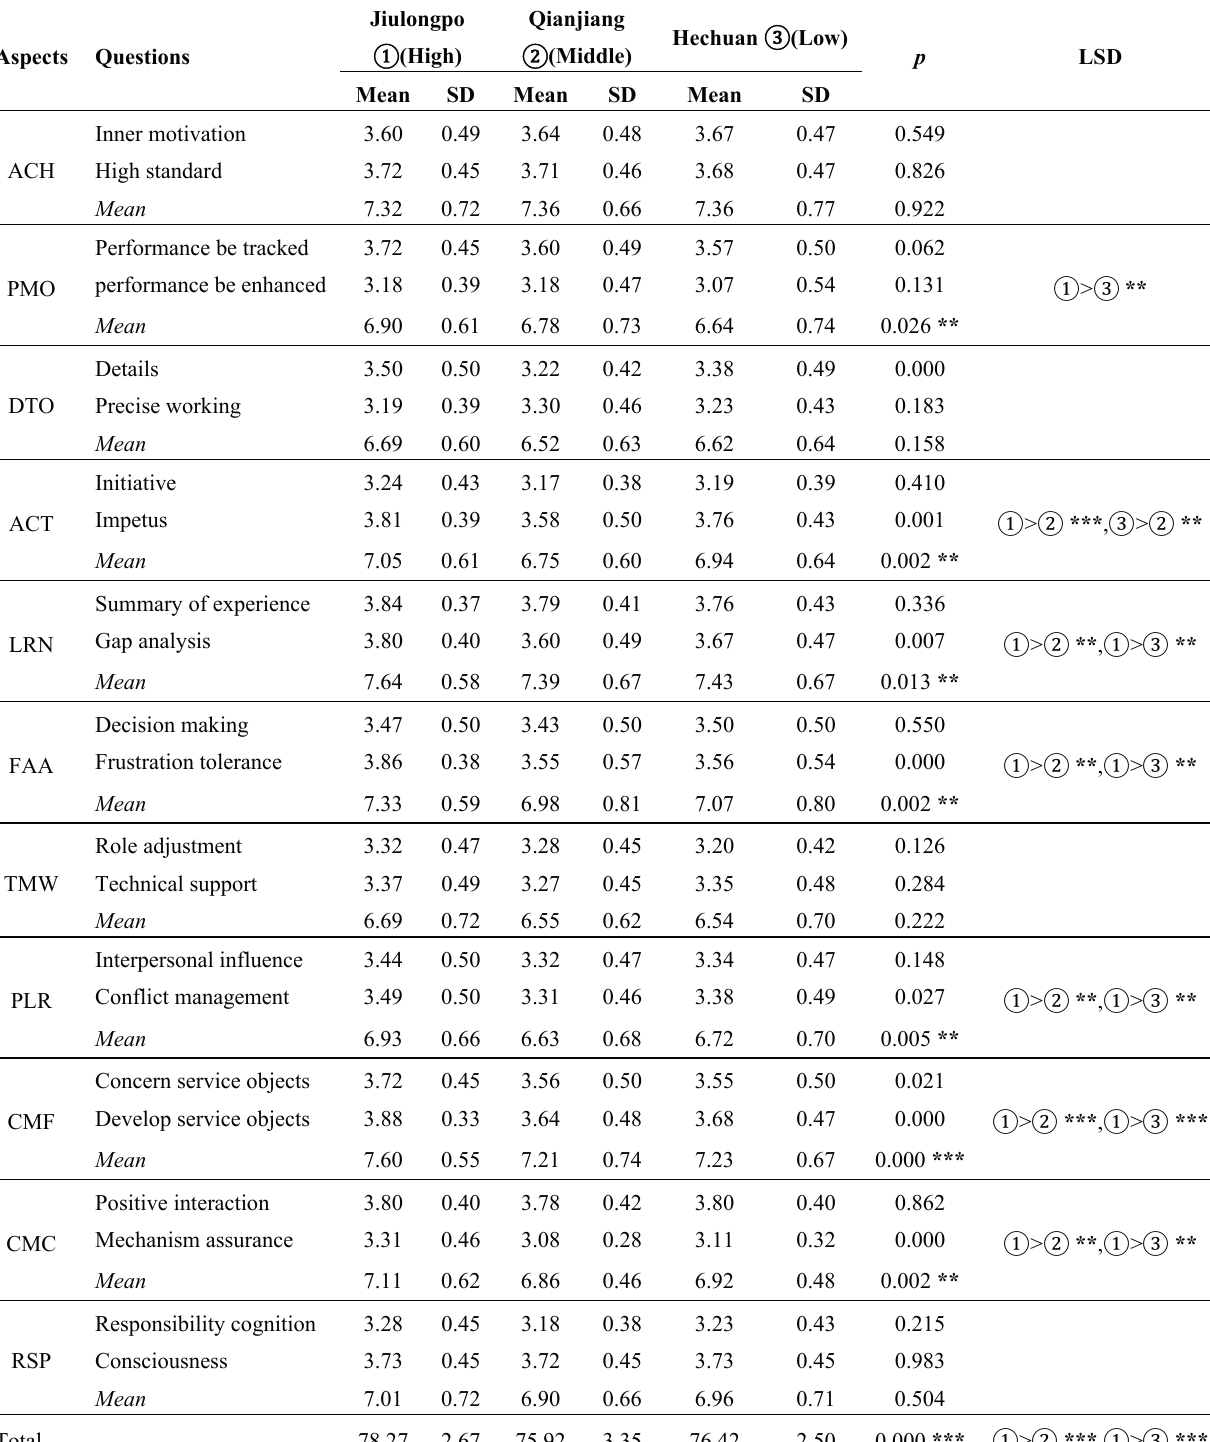
Table 3. The scores of self-evaluation competencies of PHWs in township